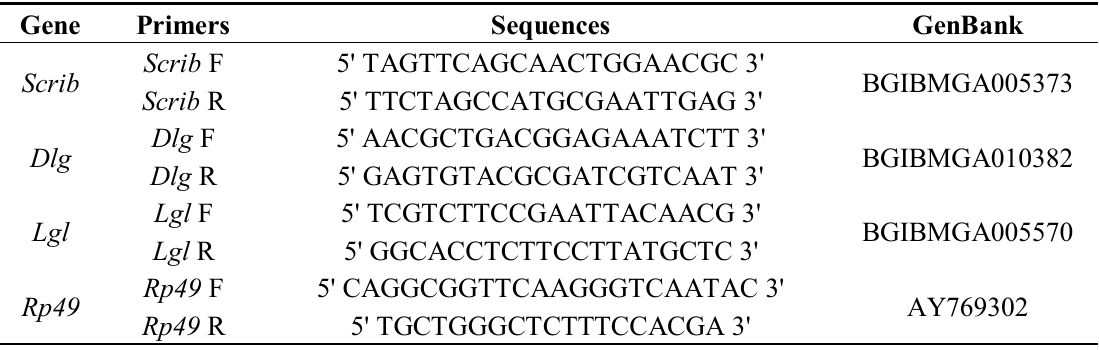
Table 1. The primers used for